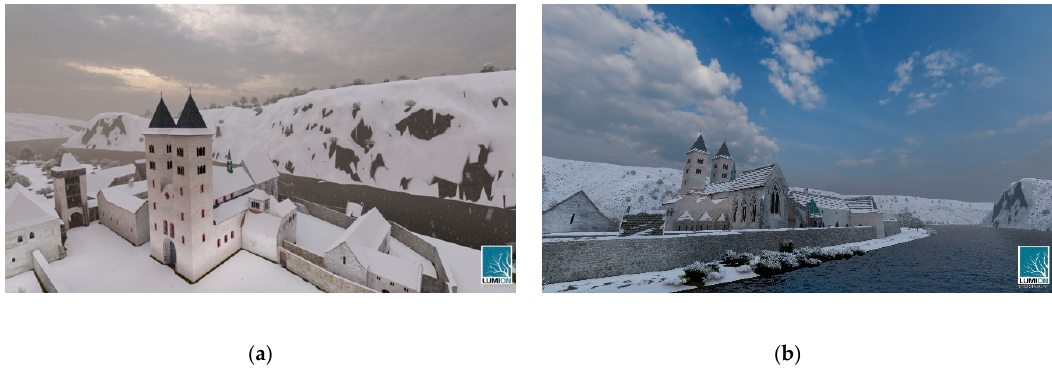
Figure 12. Visualization of the Gothic era in the winter season from southwest ( a ) and southeast ( b ).